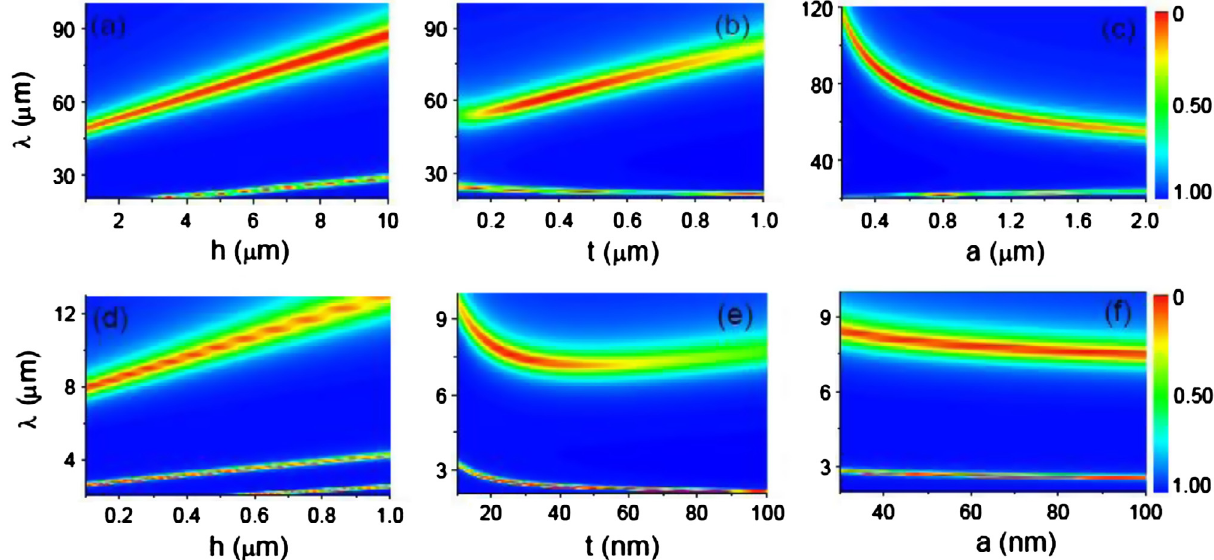
Figure 9. Reflection spectra as a function of wavelength and structure sizes for the THz (a–c) and infrared (d–f) regime. In the THz band, we fix d = 20 l m and set: (a) a = 1 l m, t = 0.5 l m; (b) a = 1 l m, h = 5 l m; and (c) h = 5 l m, t = 0.5 l m. In the infrared regime, we fix d = 2000 nm and set: (d) a = 50 nm, t = 20 nm; (e) a = 50 nm, h = 100 nm; and (f) h = 100 nm, t = 20 nm.